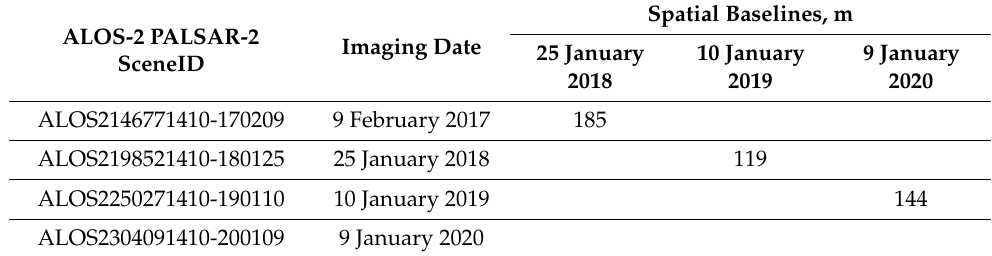
Table 1. Used ALOS ‐ 2 PALSAR ‐ 2 data.